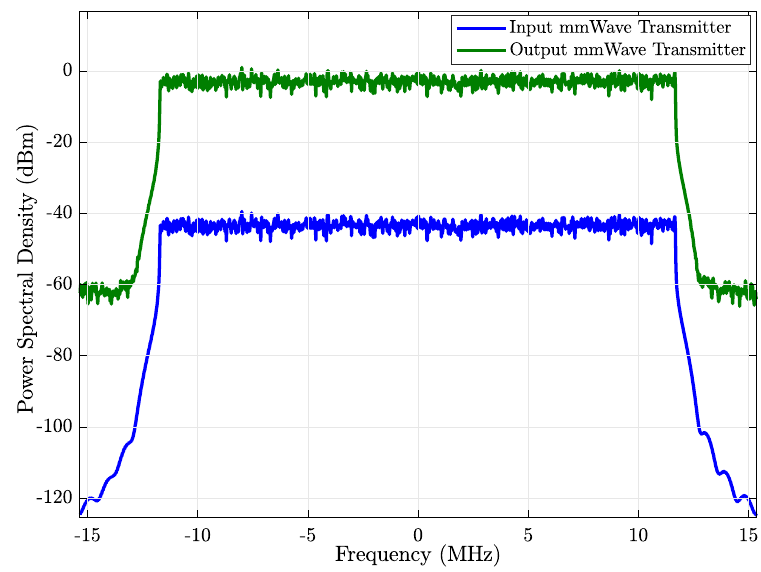
Figure 8. Spectrum of the input and output of the mmWave RF transmitter chain.